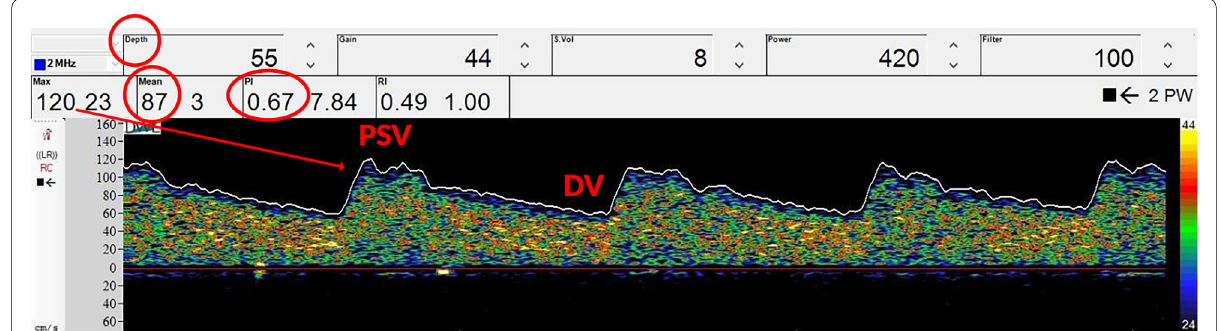
Fig. 1 Representation of the transcranial Doppler ultrasonography showing cerebral blood flow velocity. PSV, peak systolic velocity; DV, diastolic velocity; MFV, mean flow